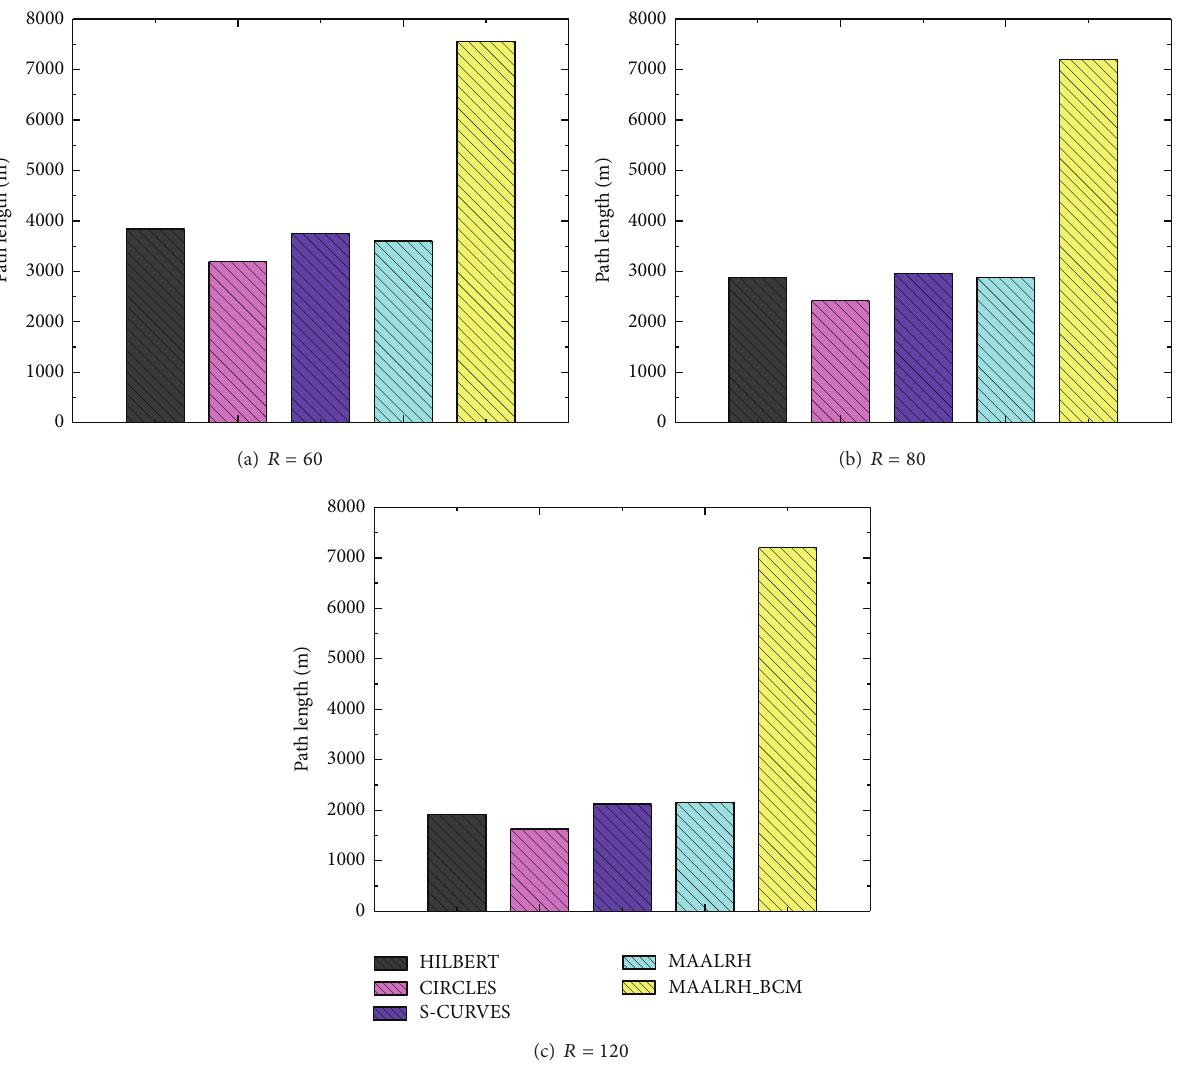
Figure 12: Path length with different resolutions.